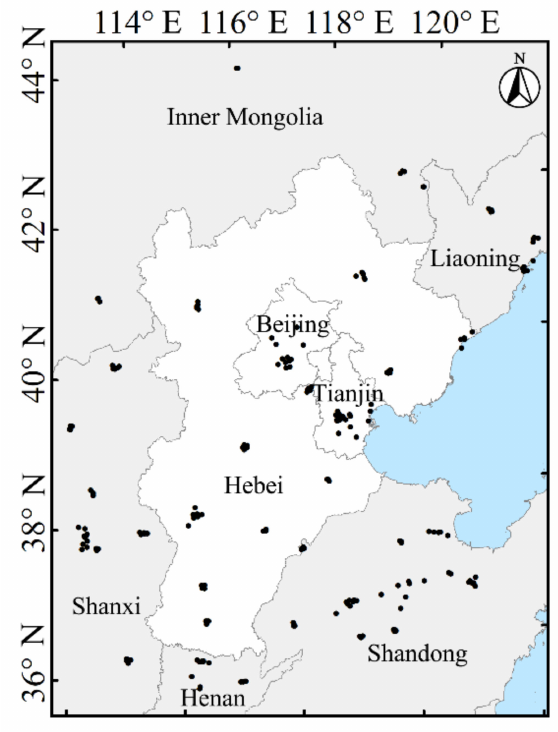
Figure 3. Spatial distribution of the air quality monitoring sites in the study area and surrounding areas. Table 3. Comparison of R 2 between the traditional and improved models.